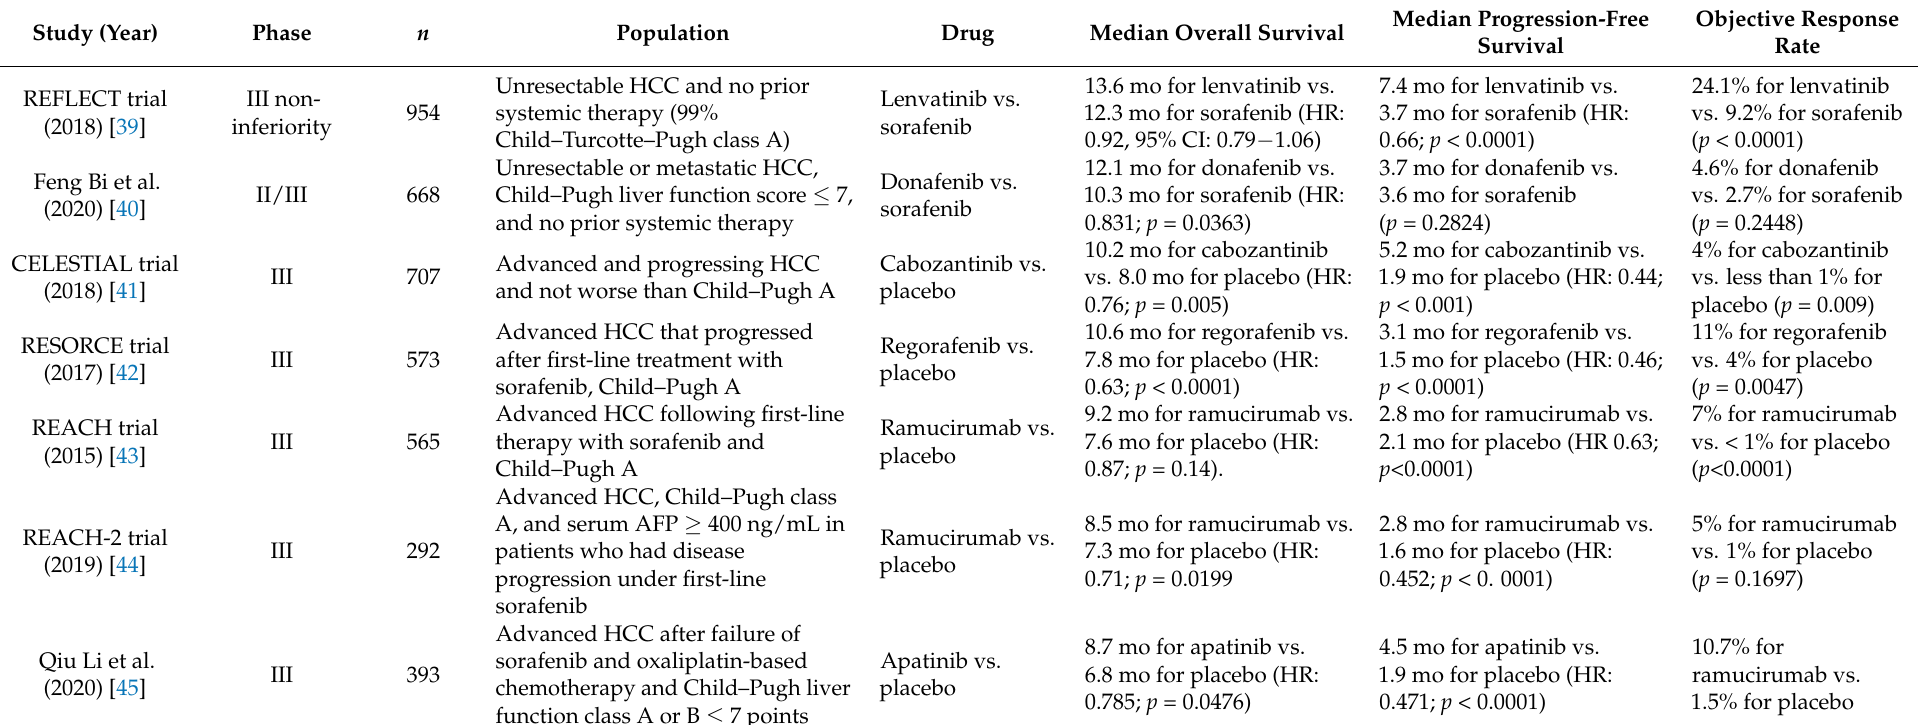
Table 2. Results of selected studies testing targeted therapies in HCC